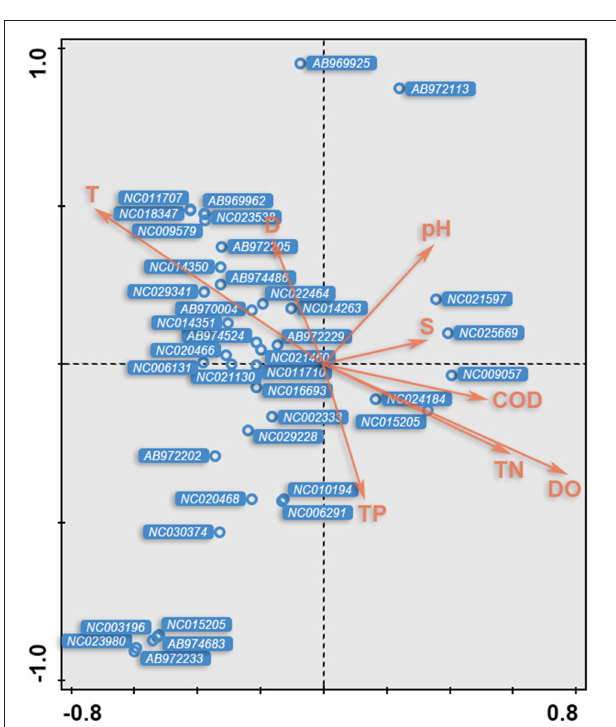
FIGURE 6 | The CCA biplot of fish species; OTUs ID were in italic and referred to Table 2 .